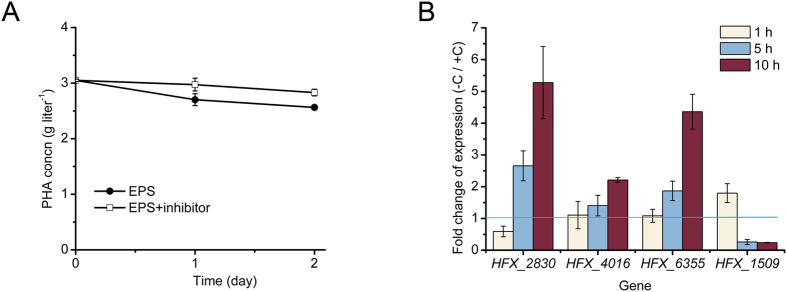
The involvement of β-oxidation pathway in PHA mobilization in H. mediterranei.(A) The inhibitors of β-oxidation enzyme inhibited PHA mobilization in H. mediterranei. EPS, H. mediterranei EPS; Inhibitor, acrylic acid (11 mM) plus thioglycolic acid (1.2 mM). (B) qRT-PCR assay for analysis of the fold change of gene expression when H. mediterranei EPS cultured in fresh PAC medium without (−C) vs with (+C) glucose. Genes HFX_1509, HFX_2830, HFX_4016, and HFX_6355 encoding the 3-hydroxyacyl-CoA dehydrogenase in β-oxidation cycle were chosen. The fold change of gene expression at 1 h, 5 h, and 10 h was analyzed. The fold change of expression of each gene was calculated by normalization to the expression of inner control 7S RNA.